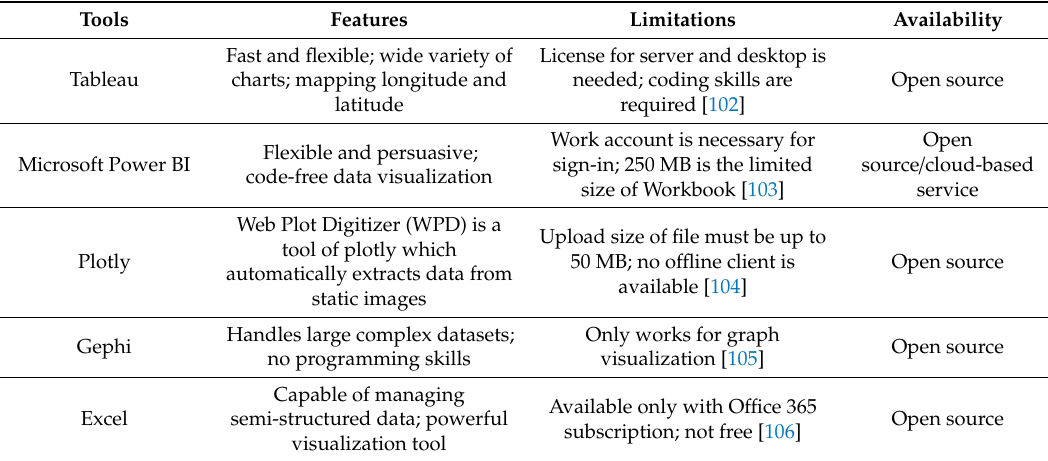
Table 11. Comparison of data visualization tools.